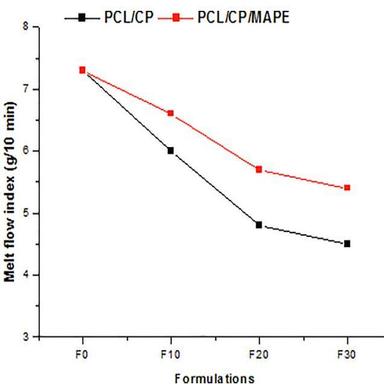
Evolution of the melt flow index of composites PCL/CP with and without compatibilizer agent.